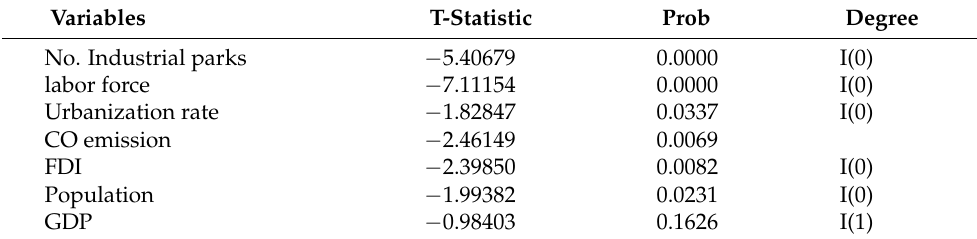
Table 3. The unit root